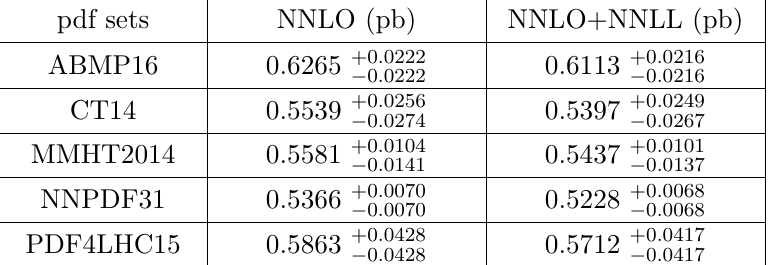
; (cid:22) c ) = (1 ; 1 = 4) m h . The strong coupling is used from the r f